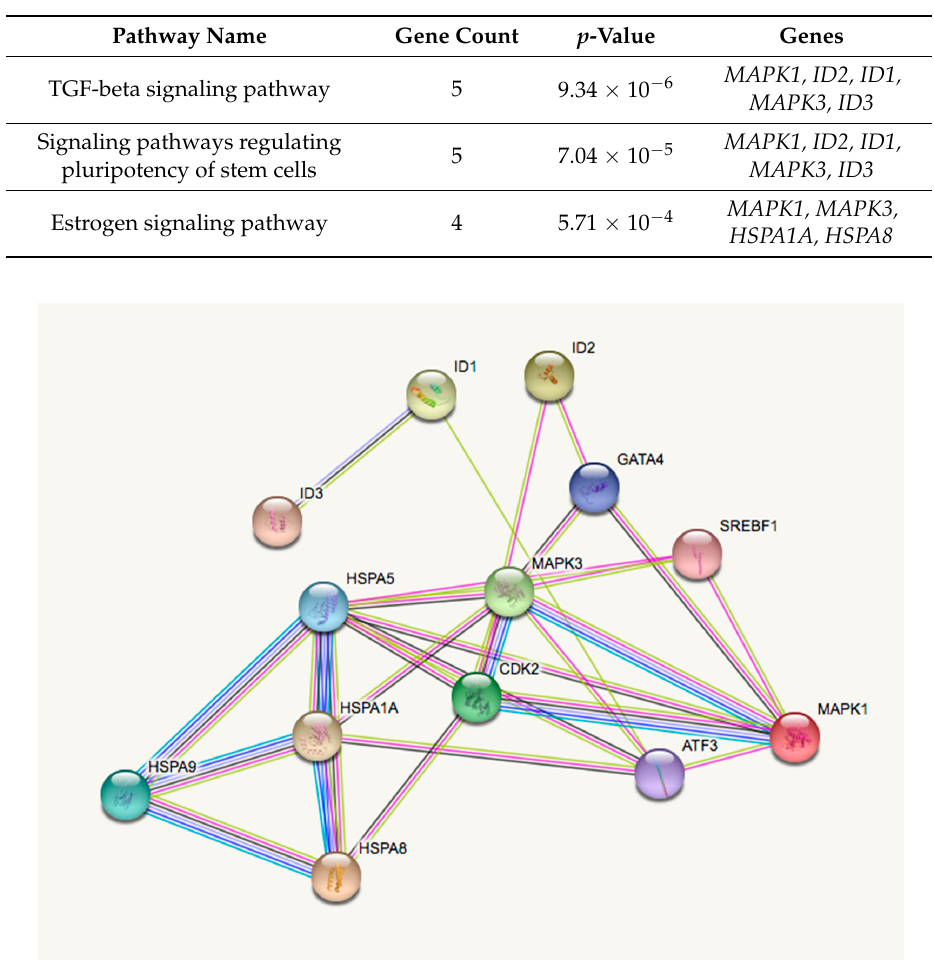
Figure 3. The gene network demonstrates a fully connected structure between the overlapping ID protein, EED, and depression genes.